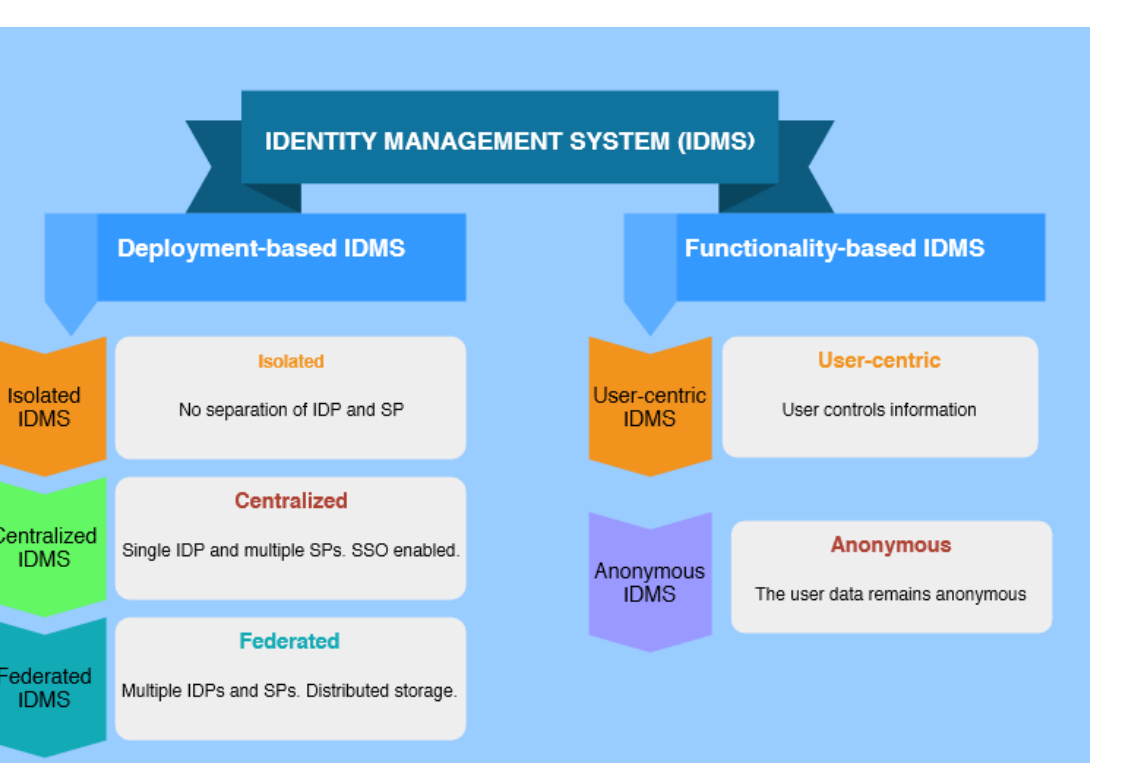
Figure 1. Classifications of an identity management system